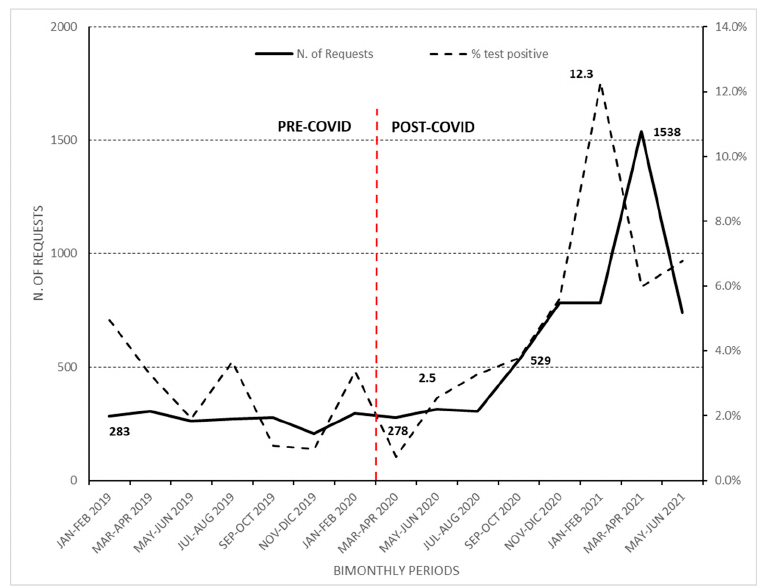
Figure 1. Distribution of the number of requests for GM-Ag tests and percentage of positive re- sults at bimonthly intervals. January 2019–February 2020 was identified as the pre-COVID period;